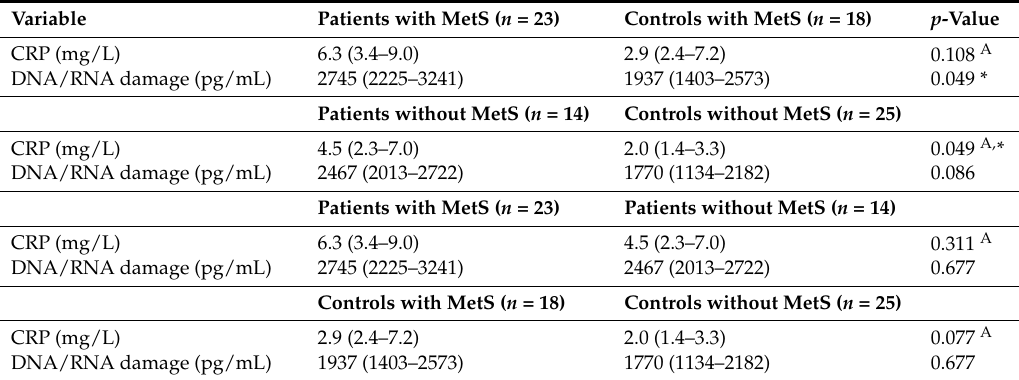
Table 2. The level of oxidative damage to nucleic acids and the level of systemic inflammation (CRP) in the group of patients and in the group of controls, depending on the presence of MetS (metabolic